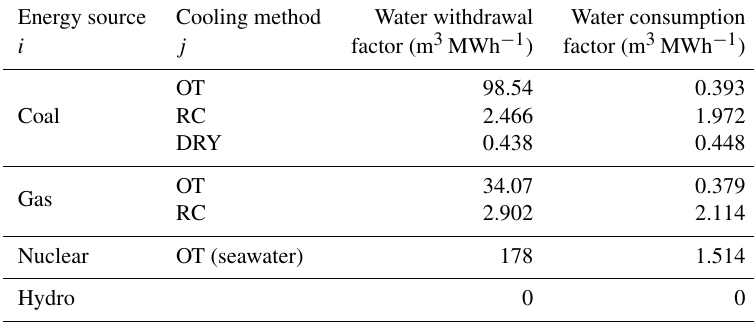
Table 2. Water withdrawal and consumption factors for electricity production.